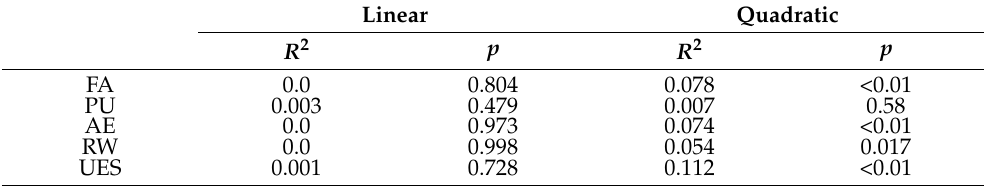
Table 6. Color Variance relation to user engagement scale (short form) for linear and quadratic model. Linear Quadratic